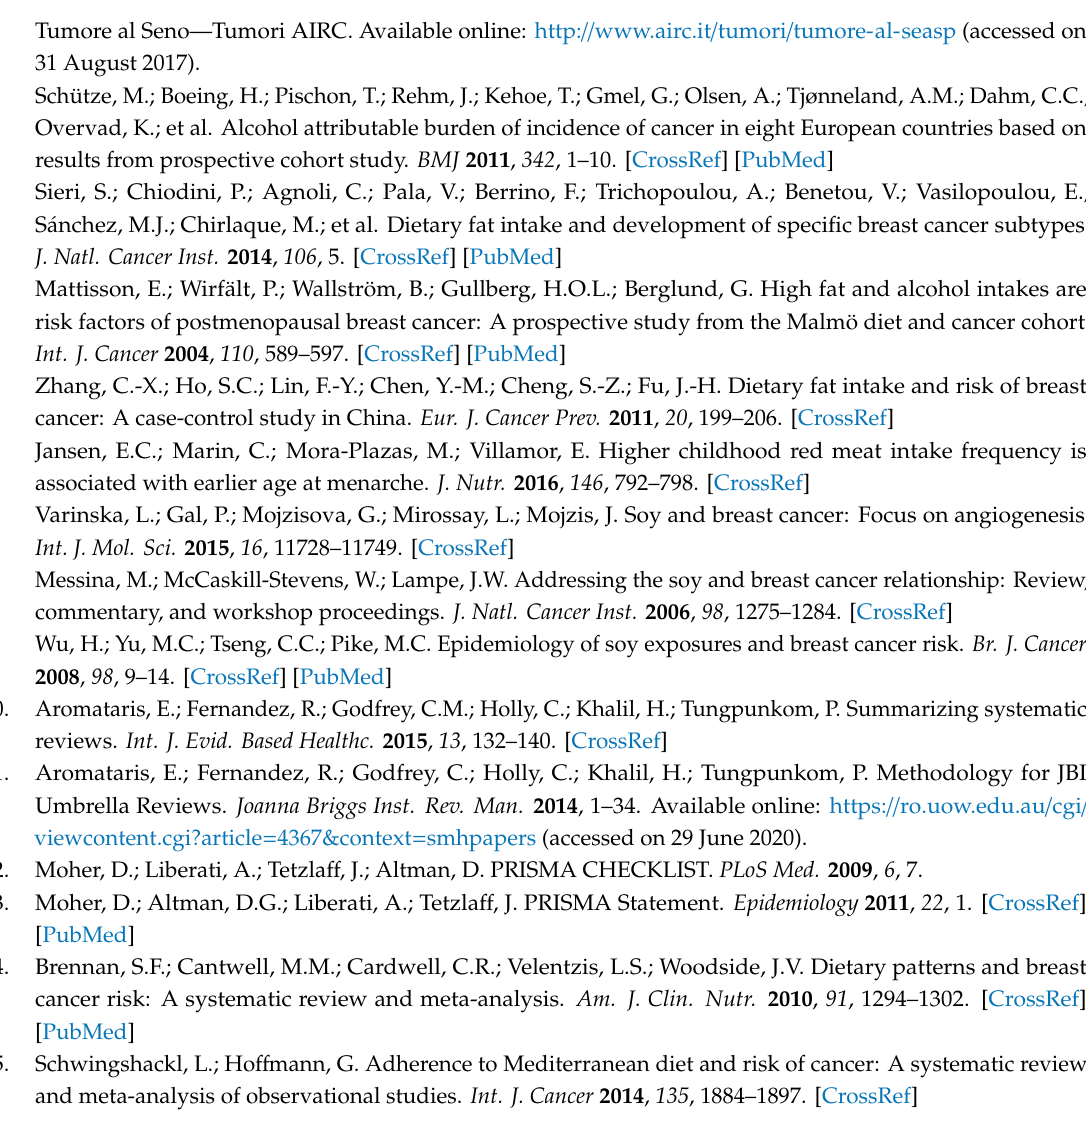
Table S1: Summary of measures of BC risk associated with dietary exposures—For META-ANALYSES only; Table S2: Summary of measures of BC risk associated with dietary exposures; Table S3: Quality of studies included in the umbrella